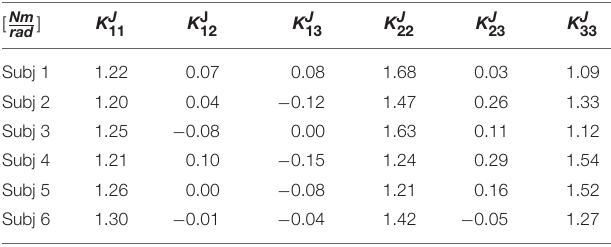
TABLE 1 | Subject-specific intrinsic stiffness ( K J ) parameters estimated via NIO from the average postural strategy.